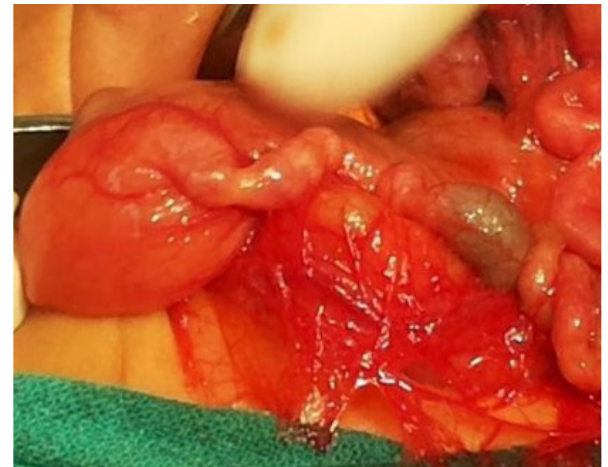
Figure 4. Jejunal atresia type I. Table 3. Postoperative complications